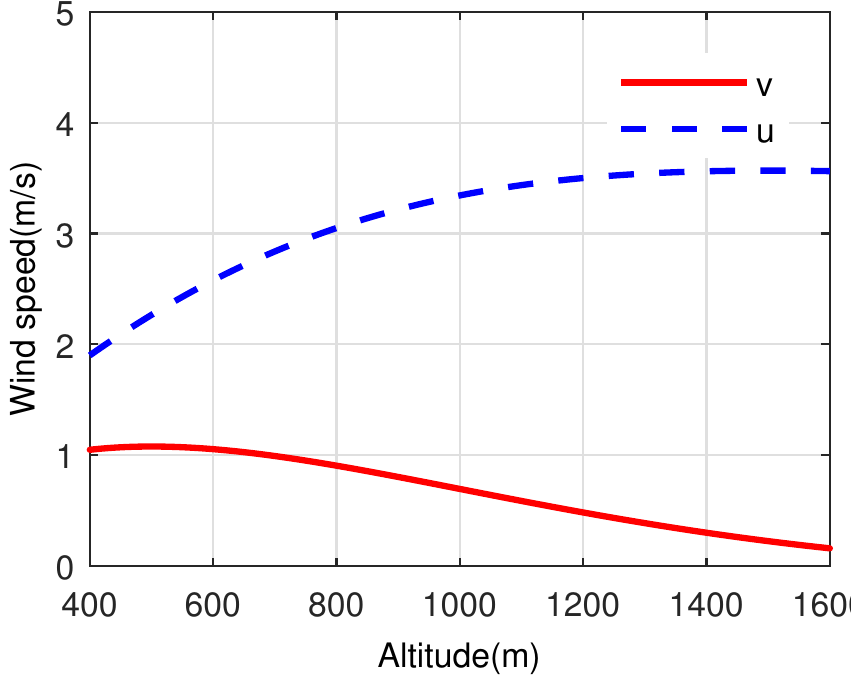
Figure 9. Average wind speed prediction results.